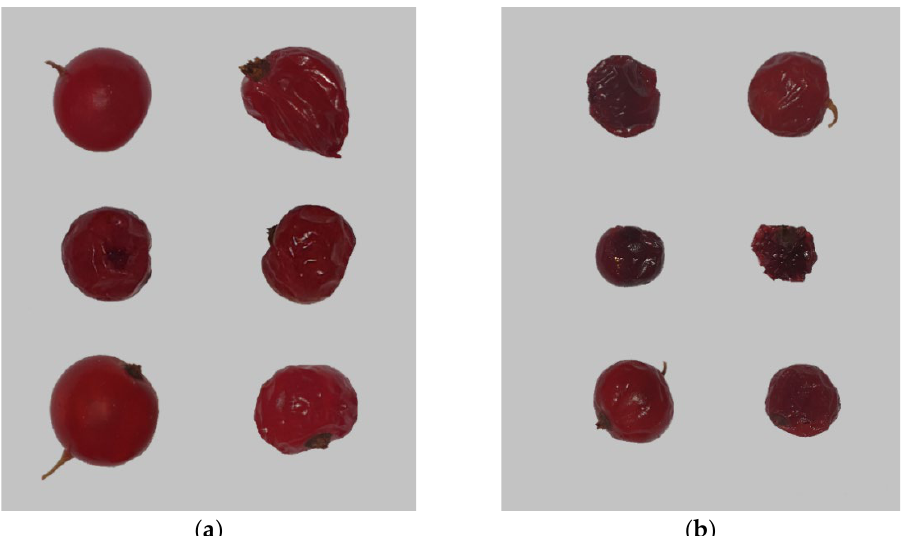
Figure 2. Images of selected red currants stored at room temperature for one week ( a ) and two weeks ( b ).